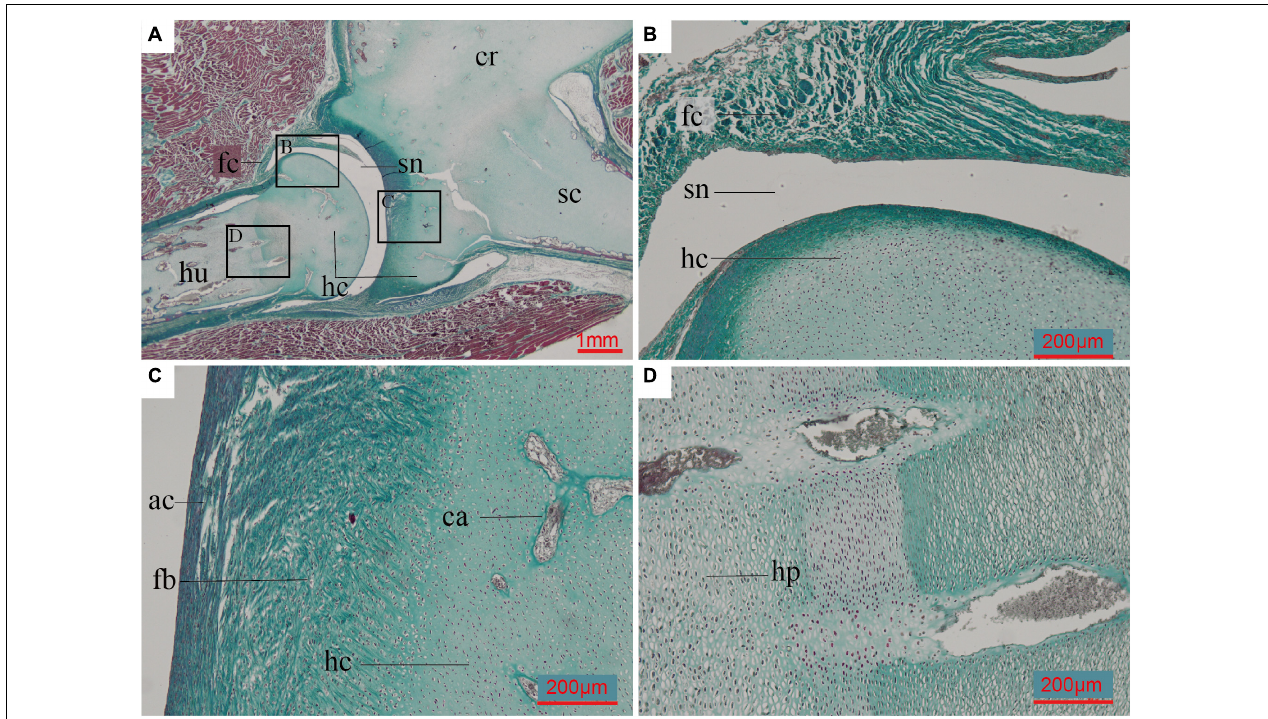
FIGURE 6 | Paraffin thin-section showing the histology of pectoral girdle of an 8-day-old Struthio camelus (Common ostrich). (A) Thin-section of the shoulder joint. It shows a synovial joint between the humerus and the already fused (but still mostly unmineralized) cartilaginous scapulocoracoid; (B) Close-up of black box in panel (A) , showing the synovial cavity and fibrous capsule of the synovial joint between the humerus and scapulocoracoid, and the hyaline cartilage of the humerals head; (C) Close-up of right black box in panel (A) , showing the fibroid surface of the articular surface, hyaline cartilage of the un-ossified scapulocoracoid body, and invasive cartilage canals; (D) Close-up of left black box in panel (A) , showing hypertrophic chondrocytes. ac, articular cartilage; ca, cartilage canals; fb, fibrocartilage; fc, fibrous capsule; hc, hyaline cartilage; hp, hypertrophic chondrocytes; sn, synovial cavity. Slide stained with a modified Masson’s